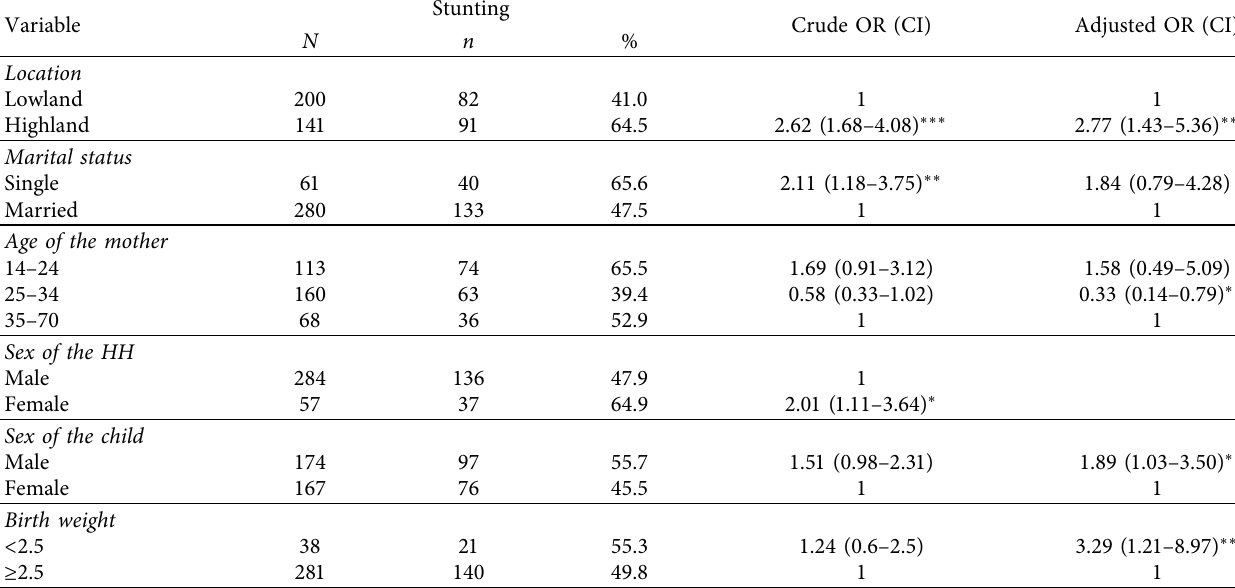
Table 5: Determinants of stunting in children: crude and adjusted OR ( N � 341).